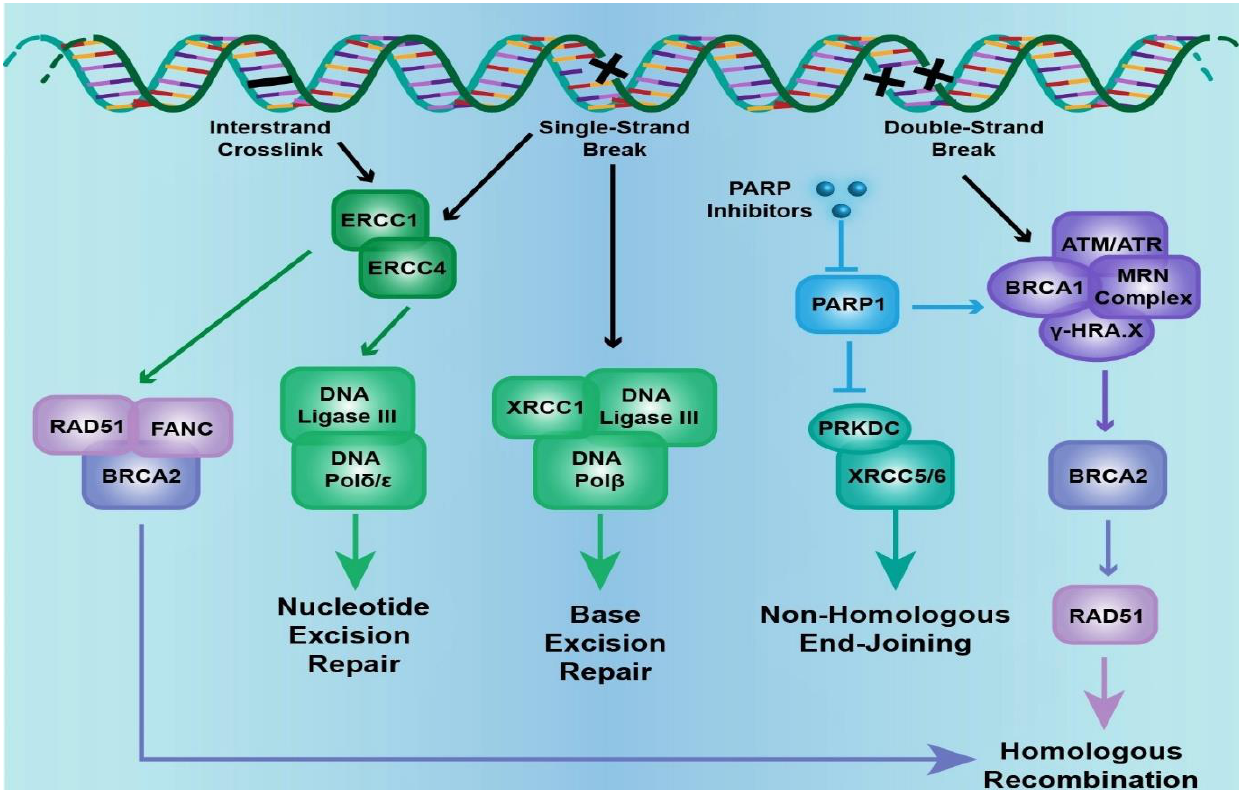
Figure 1. The cell signaling pathways that are involved in DNA damage. Excision repair cross-complementation group genes ( ERCC-1/-4 ), X-ray repair complementing defective repair in Chinese hamsters’ cell genes ( XRCC-1/-5/-6 ), poly(ADP-ribose) polymerase 1 ( PARP1 ), the Fanconi anemia gene complex ( FANC-A/-C/-D2/-E/-F/-G/-L ), Rad51 recombinase ( RAD51 ), ATM serine/threonine kinase ( ATM ), ATR serine/threonine kinase ( ATR ), protein kinase, DNA-activated catalytic polypeptide ( PRKDC ), and the breast cancer, early onset genes ( BRCA1/2 ) are included in the DNA damage pathway. Specific nodes in the pathway that are therapeutically actionable are mentioned (adapted from https://www.mycancergenome.org/).